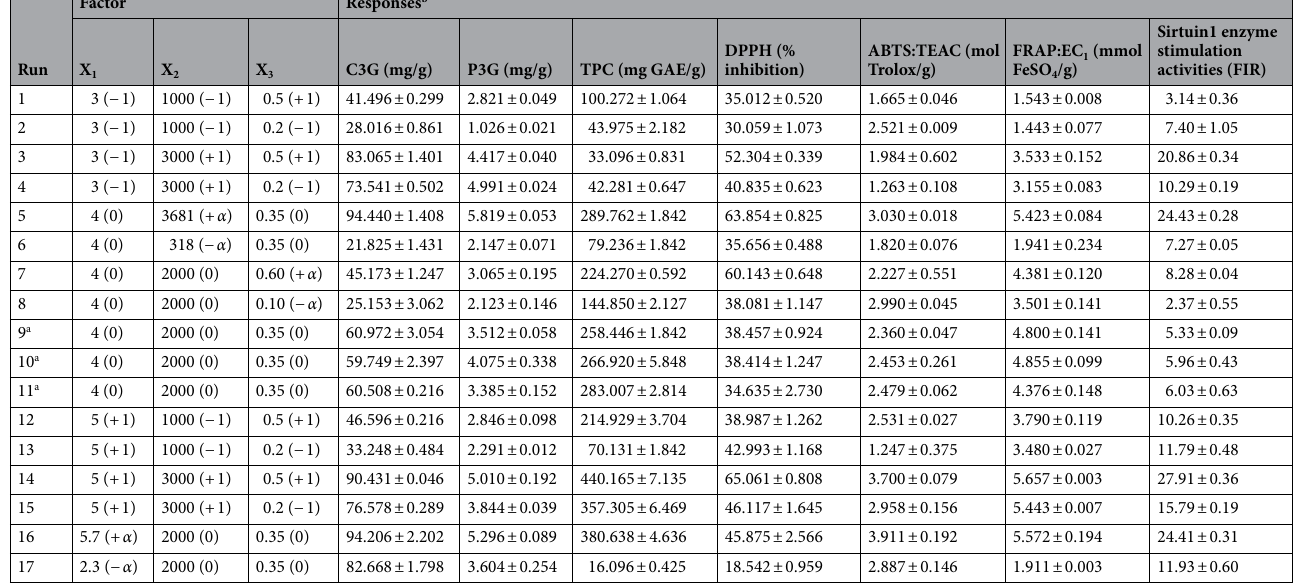
Table 2. Experimental design and observed response of PEF-AWE process of BRG. X 1 = Intensity of electric field (kV/cm), X 2 = Number of pulse (pulse), X 3 = Ratio of BRG and water(g/mL). a Three runs of center point. b Analytical results are the average of triplicates (mean ±